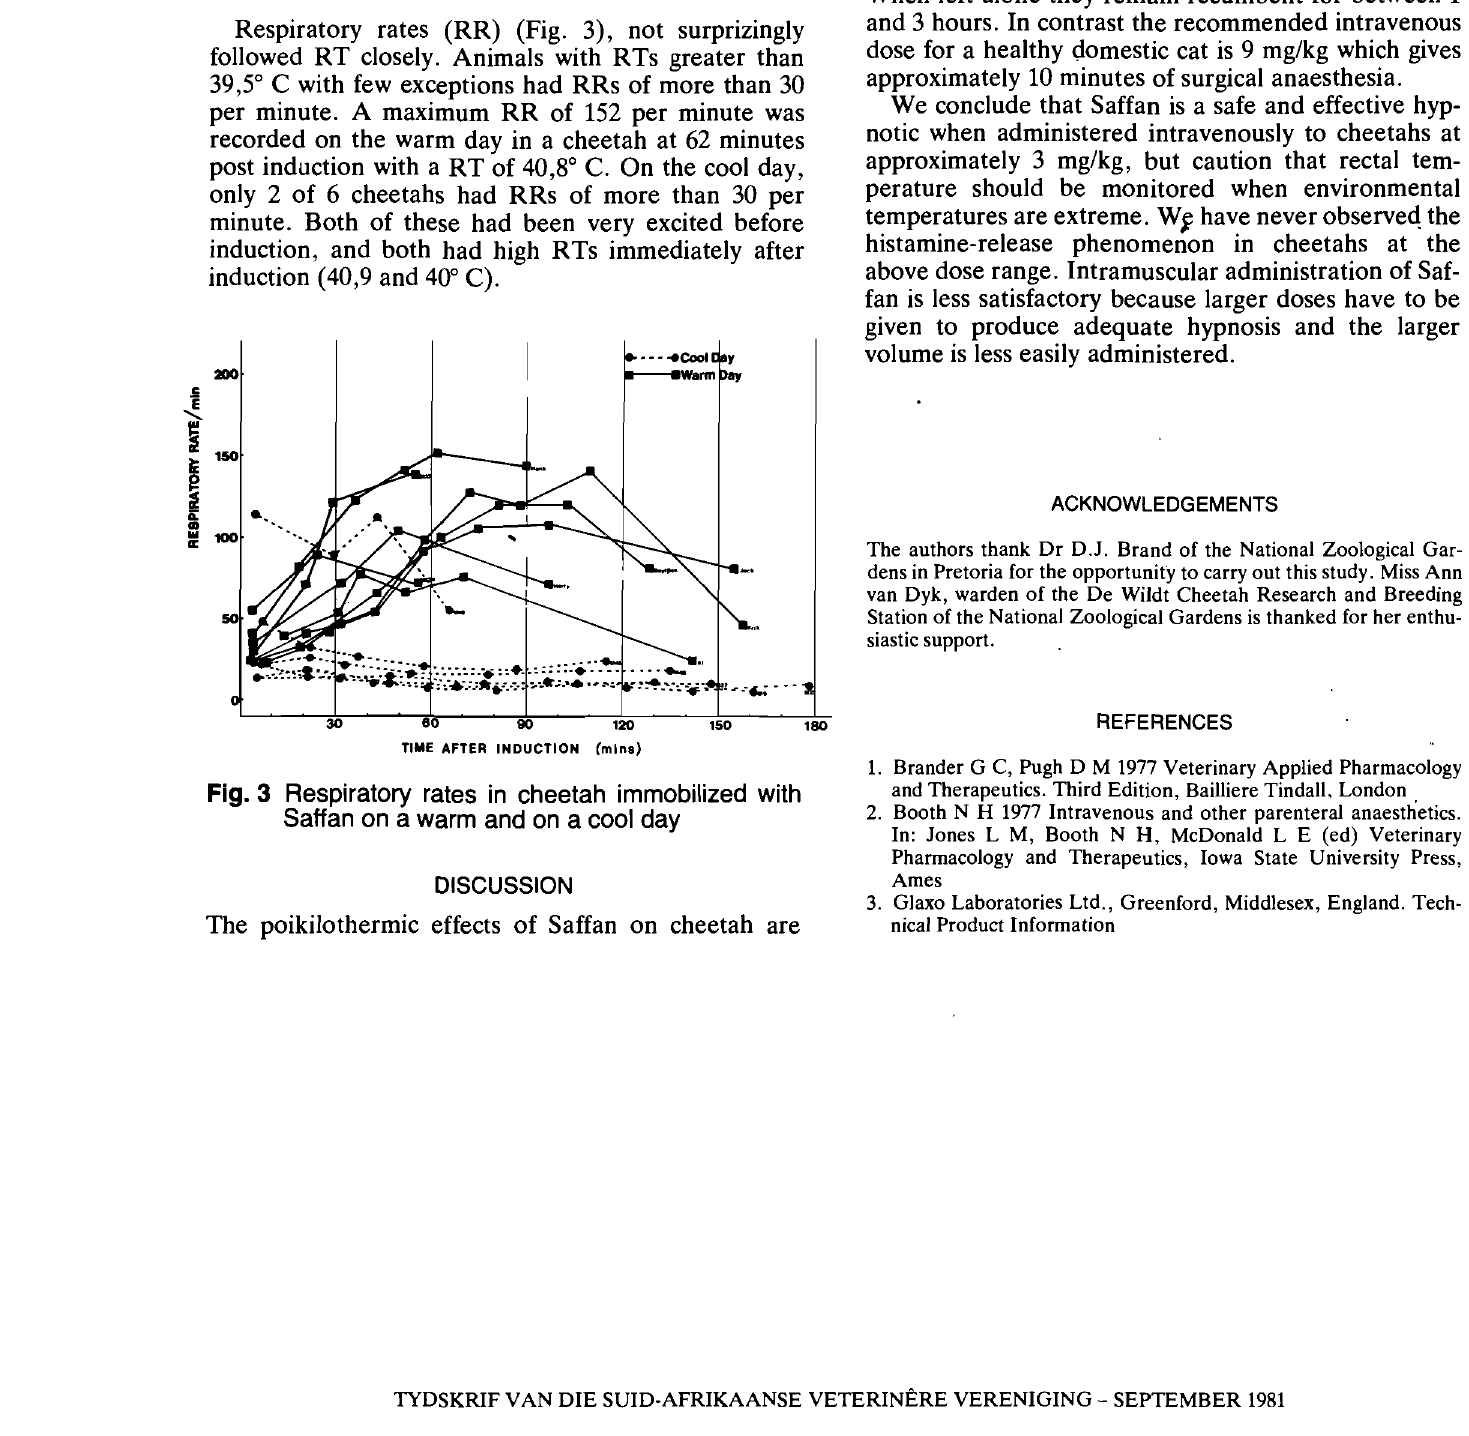
Fig, 2 Pulse rates in cheetah immobilized with Saffan